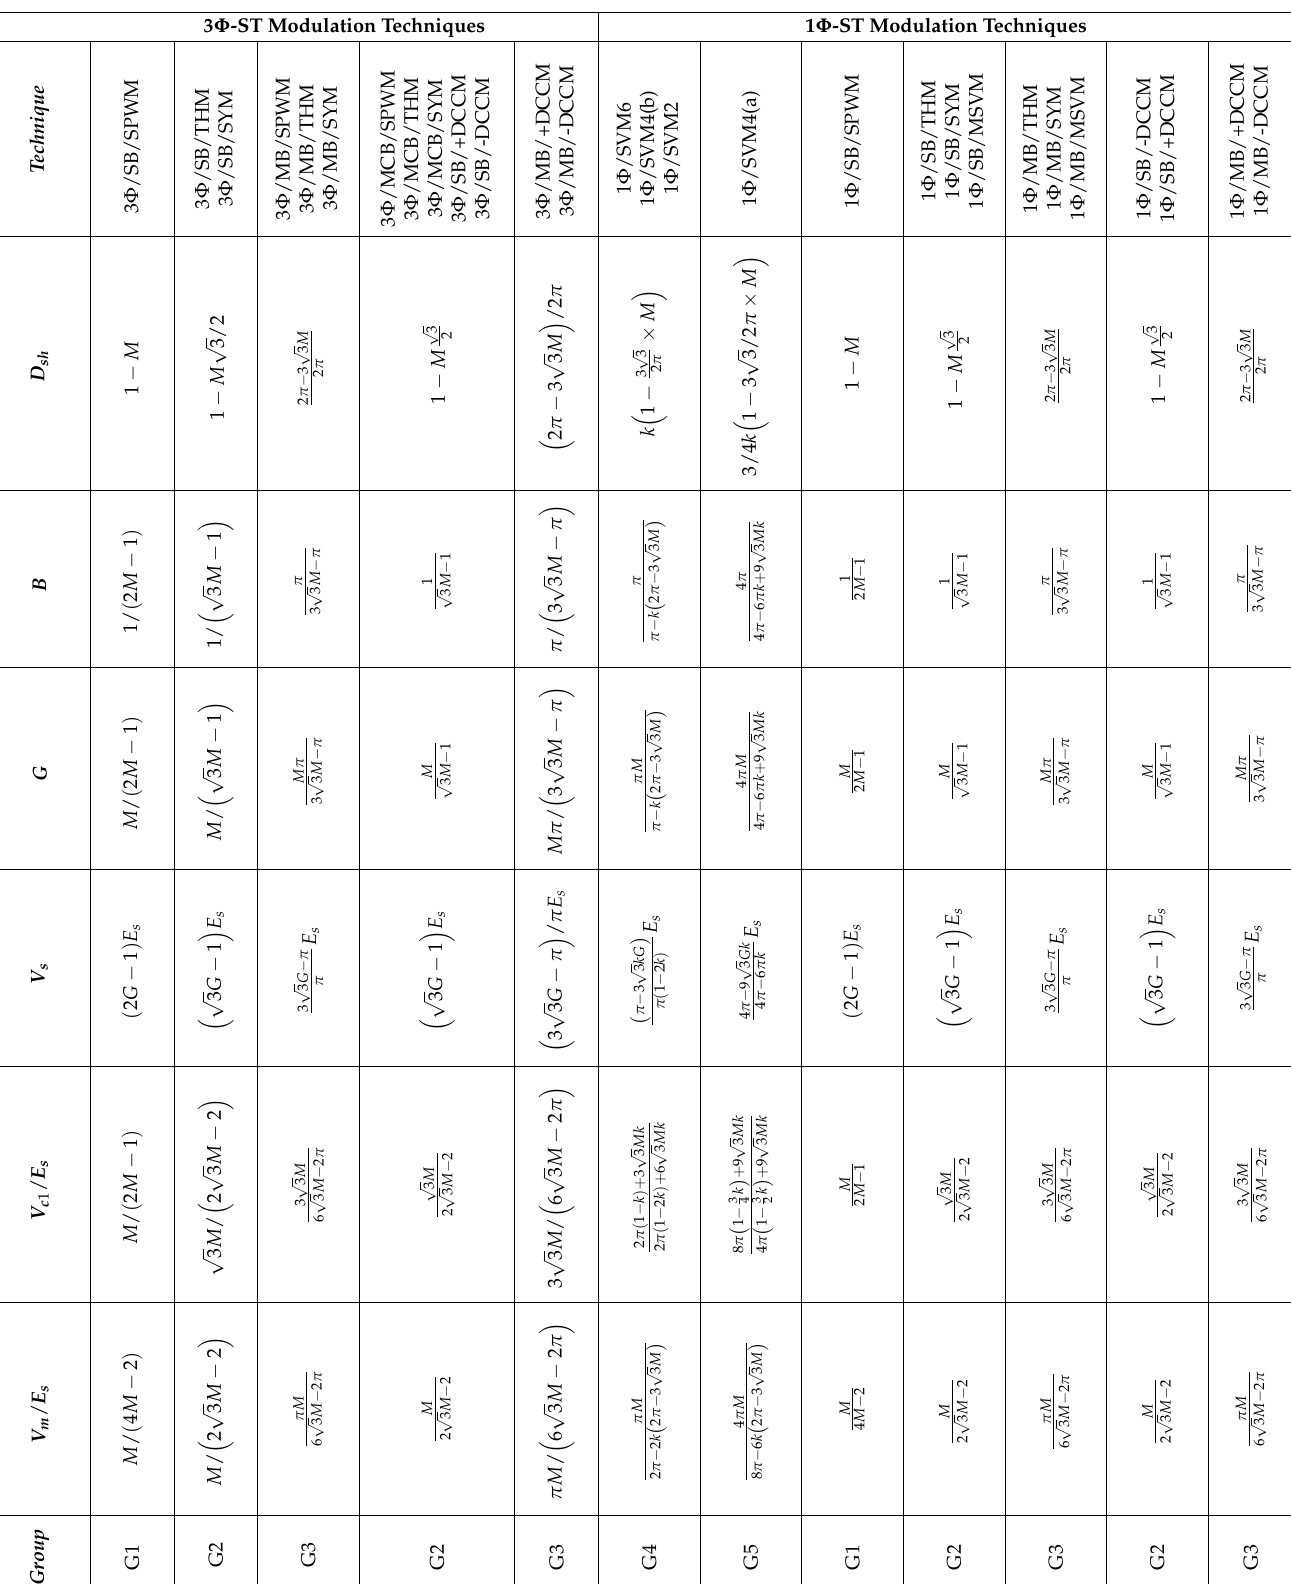
Table 1. Review summary of the modulation techniques of